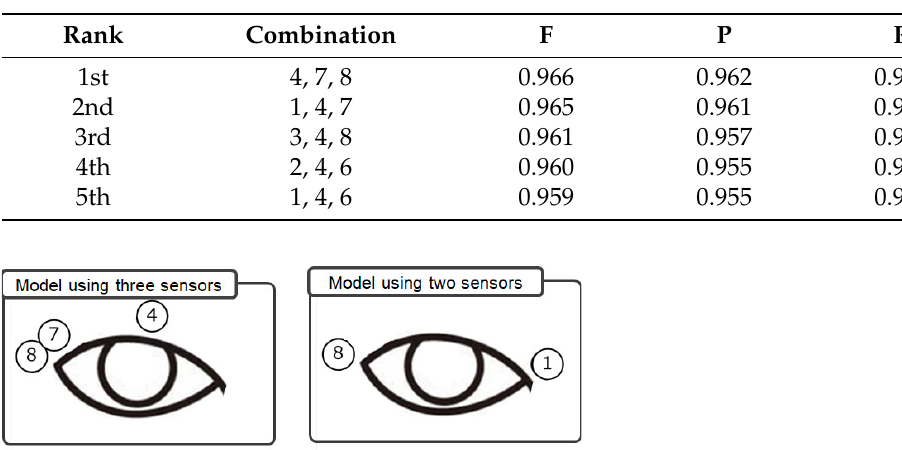
Table 4. Result of combination of three sensors with high accuracy in Evaluation 2. (R: Recall, P: Precision, F: F-value).